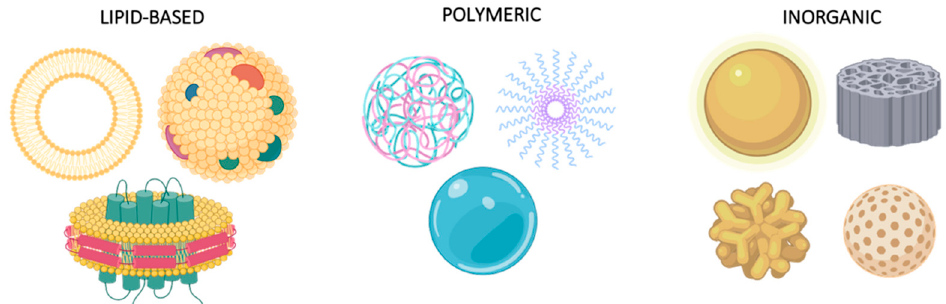
Figure 2. Common Nano Drug Delivery Systems. Nanoparticles can be classified into three main groups: lipidic particles, including liposomes, exosomes, and solid lipid disks among others, polymeric carriers, describing a wide range of vehicles such as polyplexes, micelles, and hydrogels, and inorganic nanosystems, the most heterogenous group, characterized by a variety of components (gold nanoparticles and stars, silica discs and spheres) and applications.